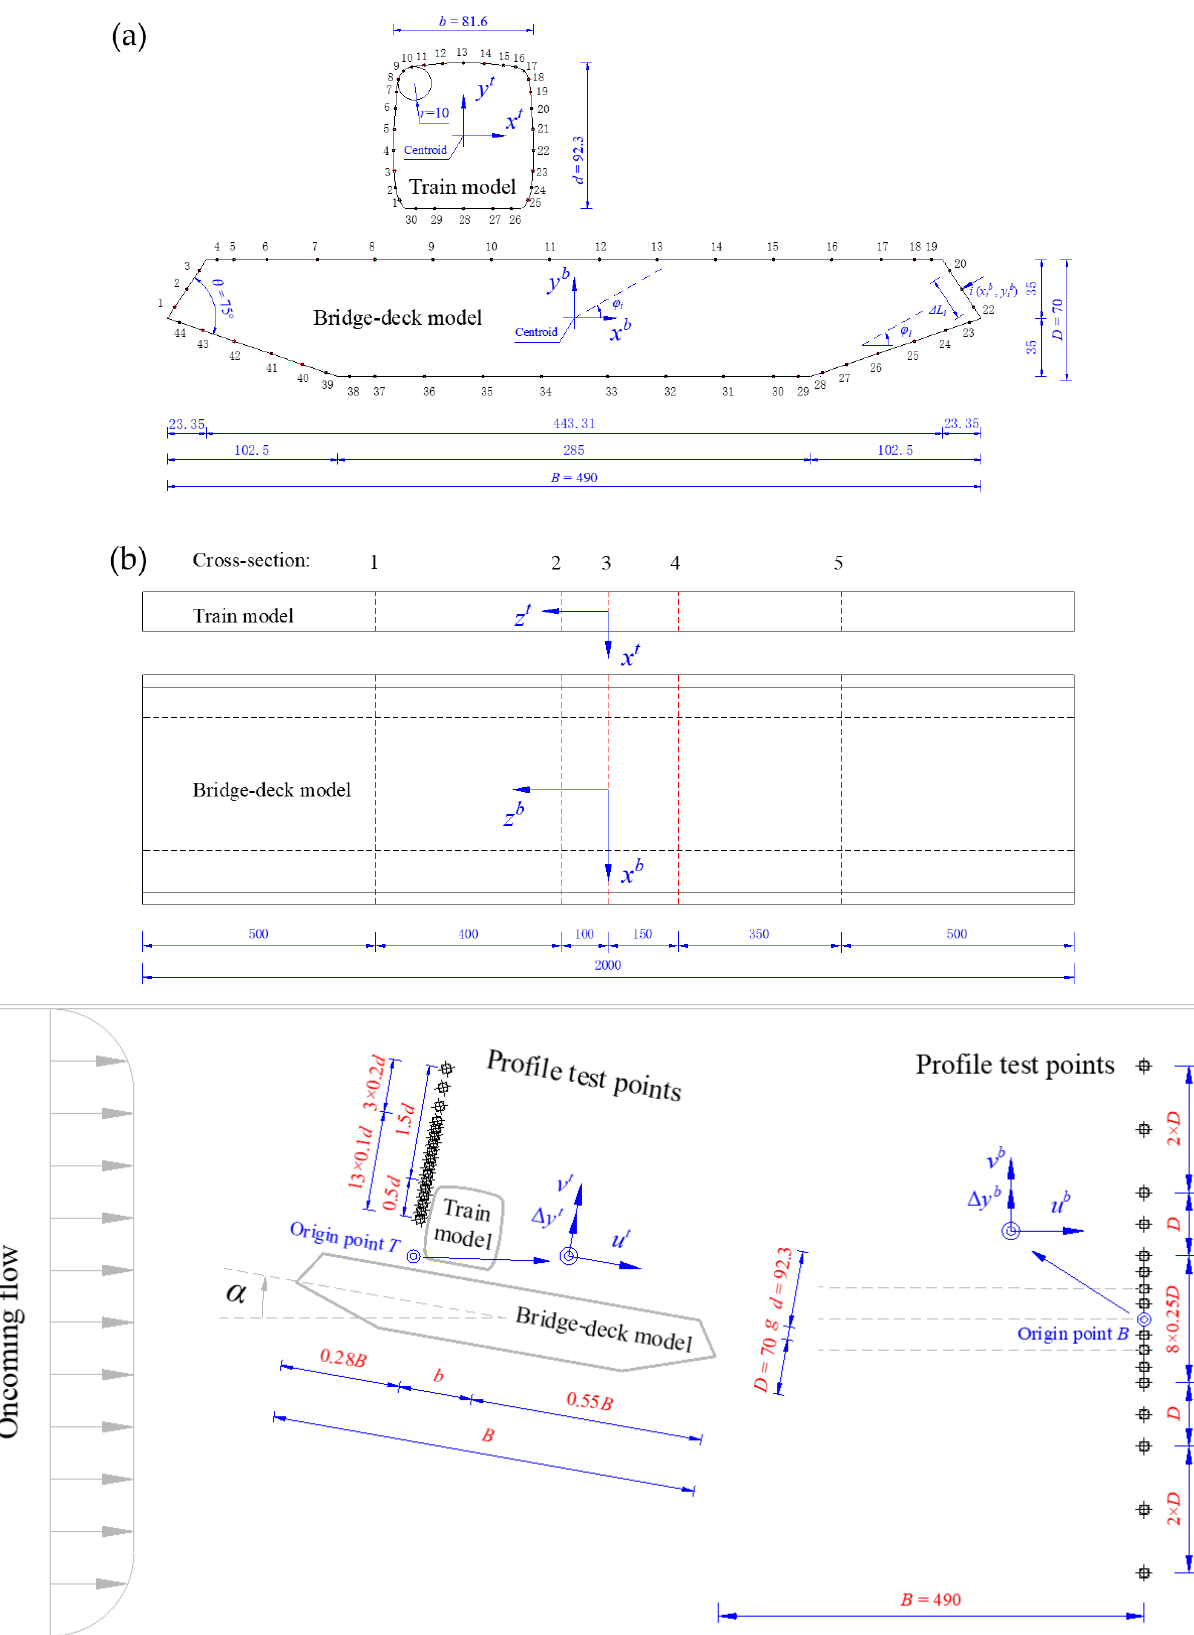
Figure 2. Model geometric parameters: ( a ) pressure test points in the lateral direction; ( b ) pressure test sections in the longitudinal direction; and ( c ) flow profile test points. (Unit: mm).